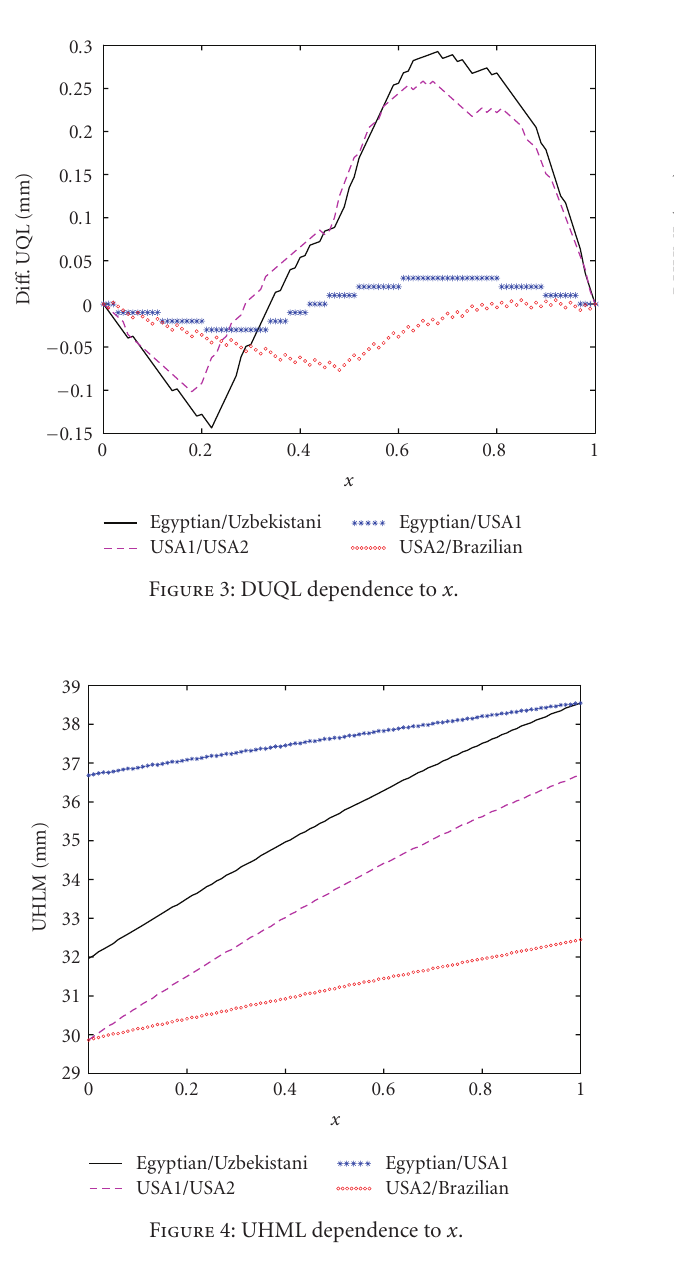
(long)/Uzbekistani (medium), the variation is less linear and DUHML can be equal to 0.5 mm when the two components have compared ratios in the blend. 6.4. Upper quarter mean length by weight (UQML) The upper quarter mean length is calculated by using (9). For the blends USA2 (medium)/Brazilian (medium) and Egyp- tian (long)/USA1 (long), the variation of UQML is nearly linear and DUQML is less than 0.2 mm. For the blends USA1 (long)/USA2 (medium) and Egyptian (long)/Uzbekistani (medium), the variation is nonlinear and DUQML can ex- tend 1 mm when the two components have compared ratios in the